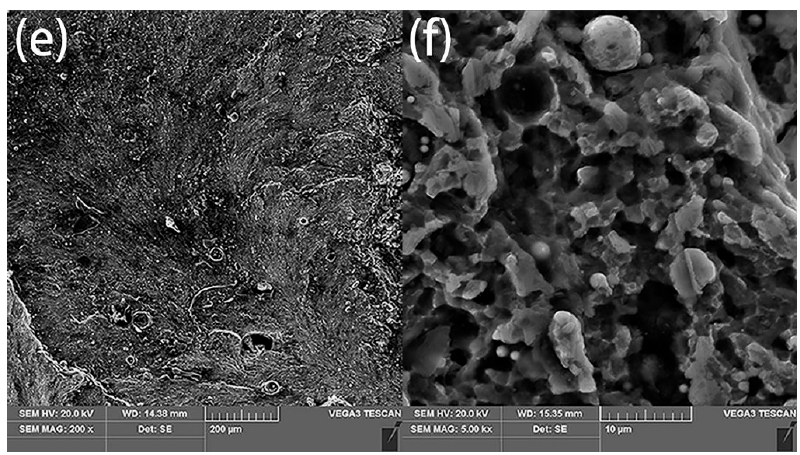
Figure 9. Weld fracture morphology ( a – f ): ( a )/( b ) macro/micro of sample I; ( c )/( d ) macro/micro of sample II; ( e )/( f ) macro/micro of sample